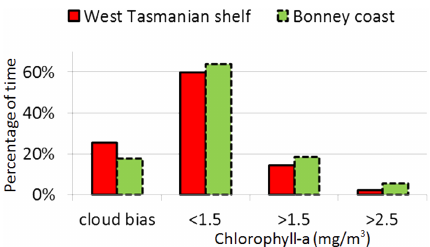
Figure 11. Event analysis. Histogram of 8-day segments for the pe- riod from 1 January 2005 to 31 March 2014 that fall within certain ranges of chlorophyll a concentrations for the western Tasmanian shelf and the Bonney coast. The result is expressed as time percent- age with reference to the entire time period. Cloud bias refers to missing